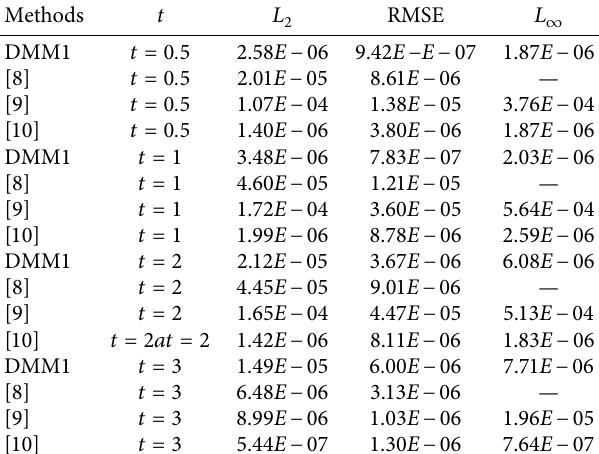
Table 7: Numerical results with α � 10and β � 5 for Example 5.